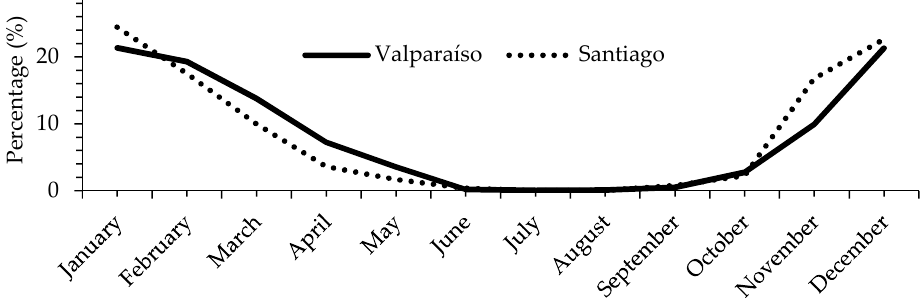
Figure 1. Wildfire occurrences in Valparaiso and Santiago regions from 2010 to 2013 (Monthly percentage).